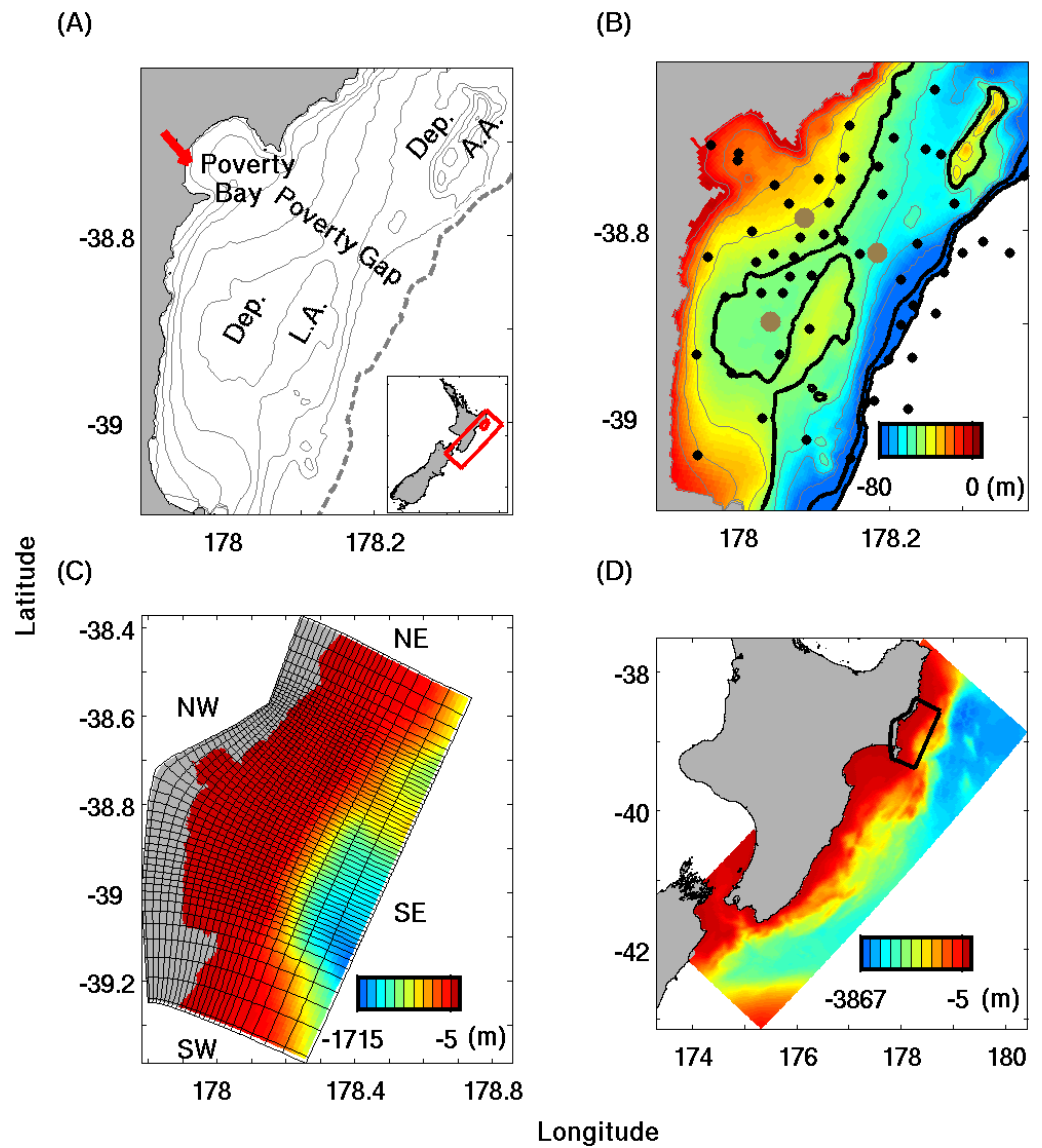
Figure 1. Study site on North Island, New Zealand. ( A ) Waipaoa Shelf map showing locations of Poverty Bay, Poverty Gap, shelf depocenters (Dep), and the Lachlan and Ariel Anticlines (L.A. and A.A., respectively). Red arrow indicates river mouth. Grey bathymetric contours drawn every 10 m up to 70 m depth, while dashed grey line indicates shelf break at 150 m. Inset shows location of study site within the larger-scale model. ( B ) Waipaoa Shelf map showing shelf bathymetry up to 80 m water depth (shading; in meters), tripod locations (brown dots) and multi-core stations (black dots) from the January 2010 research cruise. Grey and black bathymetric contours drawn every 10 m to 100 m depth, then at 150 m depth. ( C ) Waipaoa model grid showing bathymetry, where each box shown encompasses 25 model cells. Model boundaries labeled ―NW‖, ―SW‖, ―SE‖, ―NE‖. ( D ) Bathymetric map of larger-scale model Regional Ocean Modeling System (ROMS)-NZ covering the eastern half of the North Island, New Zealand. Black box indicates location of Waipaoa shelf